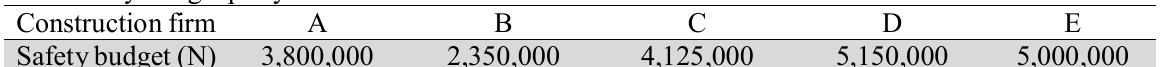
Total safety budget per year